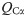
Protein folding simulations with the default Cα and all-atom models of the 64 residue chymotrypsin inhibitor 2 (PDB code: 1YPA).Top: Folding trajectories near folding temperature (TF) of the Cα (black) and all-atom (red) models. Bottom: Free energy as a function of QCα, the number of native Cα pairs within 1.5 times their native distance. The same coordinate is used to describe both models. Inset: Specific heat for the two models (normalized to have equal area). TF in reduced units for the all-atom model is 0.97 and for the Cα model is 1.17 (117 and 140 in the GROMACS .mdp file, respectively).